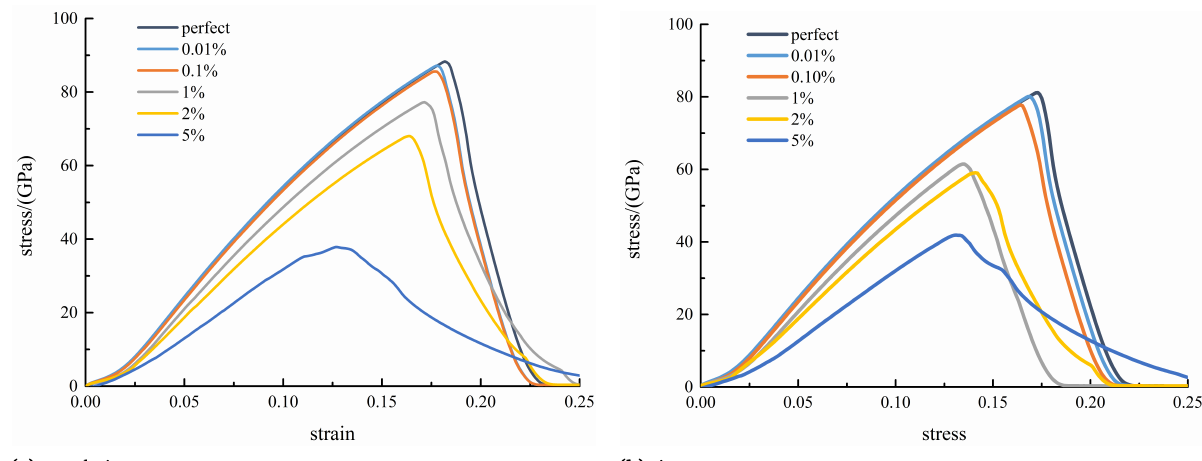
Figure 3: Stress-strain curve of BNNS at 0.01K.